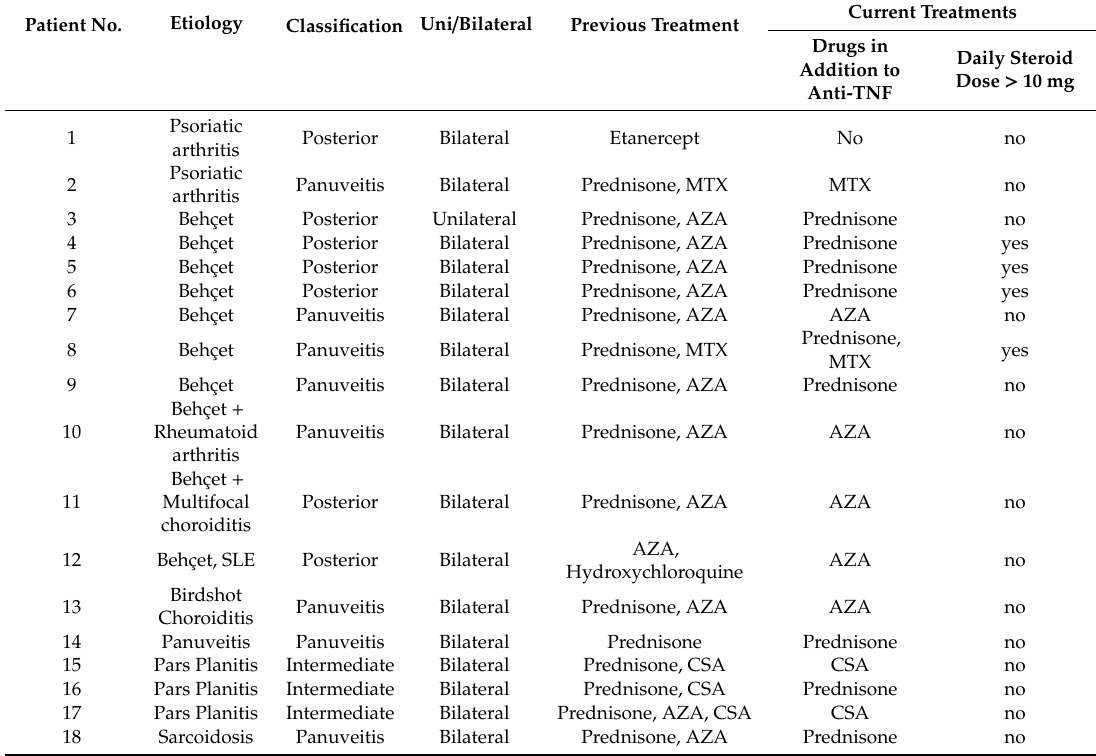
Table 1. Clinical data of enrolled